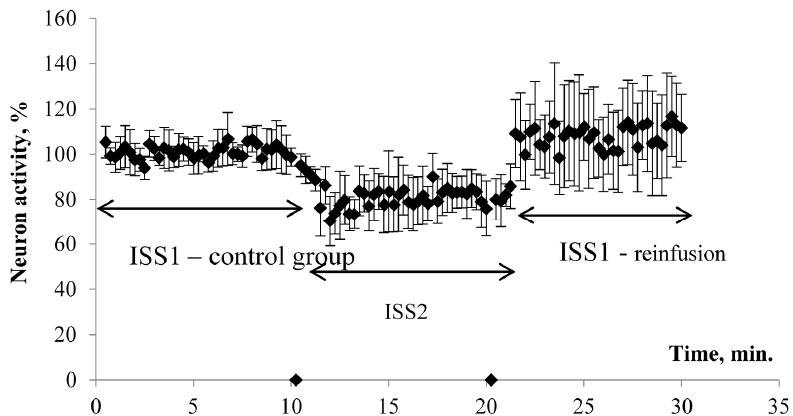
Figure 1. Decrease in the induced activity of neurons in the CA1 part of the hippocampus during